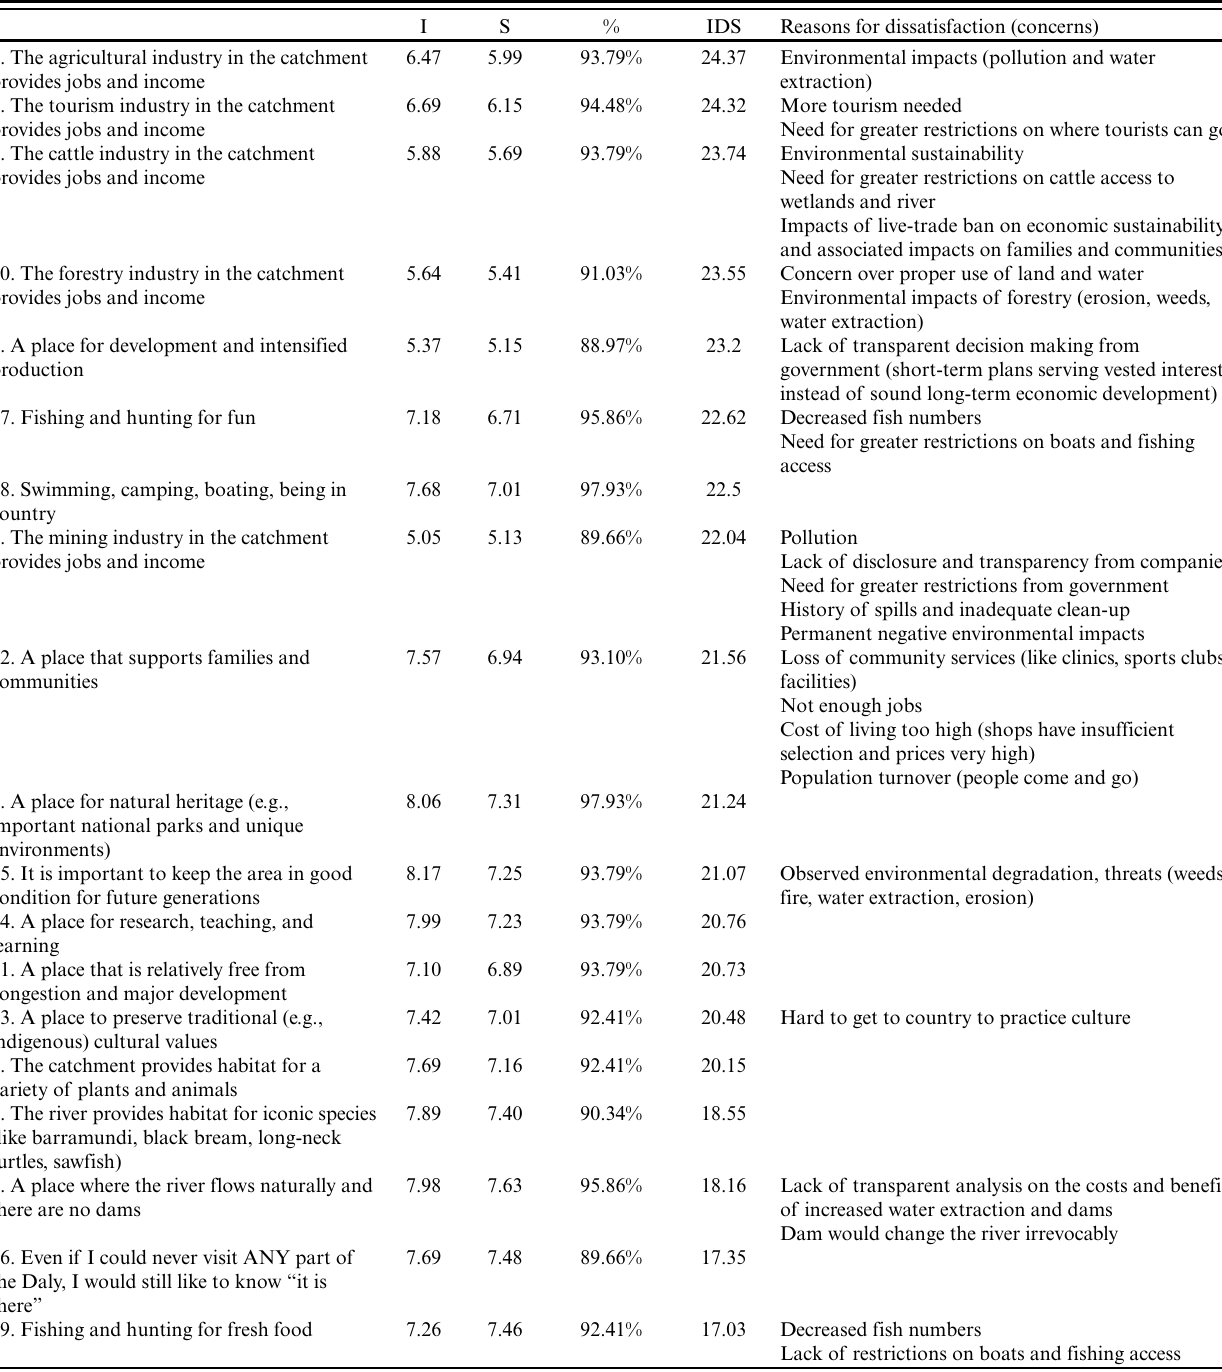
Table 5 . Index of Dissatisfaction (IDS) for well-being factors; higher values indicate greater importance, less satisfaction, and/or higher percentages of respondents providing information about the factor. The components of the IDS are provided for each factor: mean importance (I), mean satisfaction (S), and percentage of respondents who provided information about both parameters (%). Mean importance reported here might not exactly match values provided in Figure 3 because only those respondents who answered questions for both importance and satisfaction (n = 145) were included in values for IDS. Reasons for dissatisfaction reported in the survey are given for each